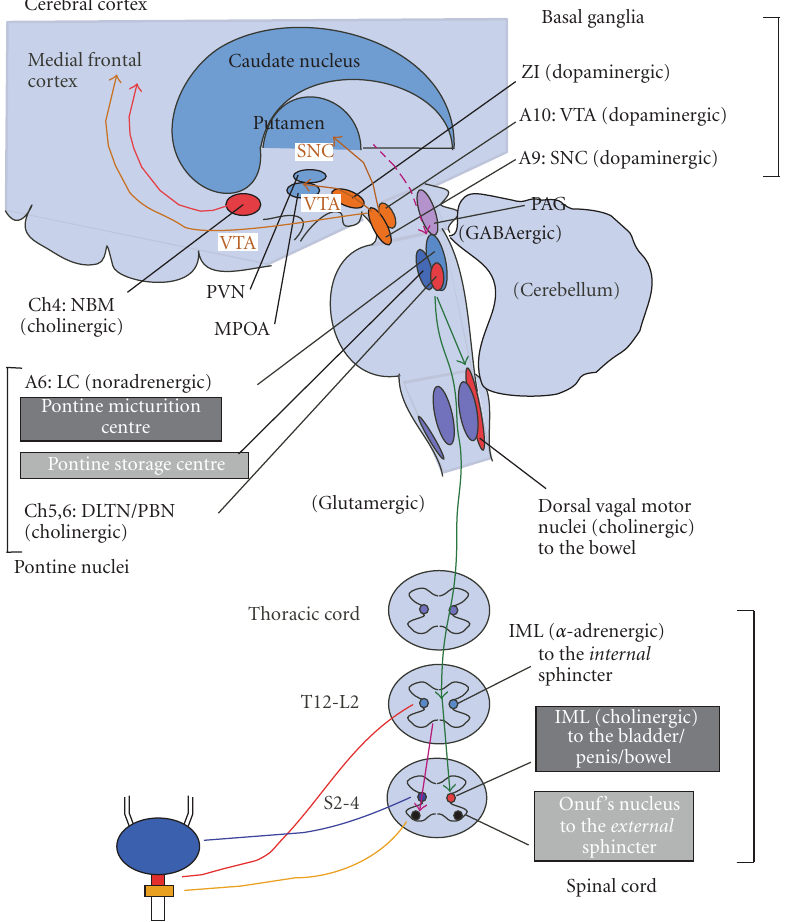
Figure 1: Neural circuitry relevant to micturition. PAG, periaqueductal gray; LC, locus ceruleus; NBM, nucleus basalis Meynert; PVN, paraventricular nucleus; MPOA, medial preoptic area; A, adrenergic/noradrenergic; ZI, zona incerta; VTA, ventral tegmental area; SNC, substantia nigra pars compacta; DLTN, dorsolateral tegmental nucleus; PBN, parabrachial nucleus; IML, intermediolateral cell column; GABA, γ -aminobutyric acid; T, thoracic; L, lumbar; S, sacral. See text.